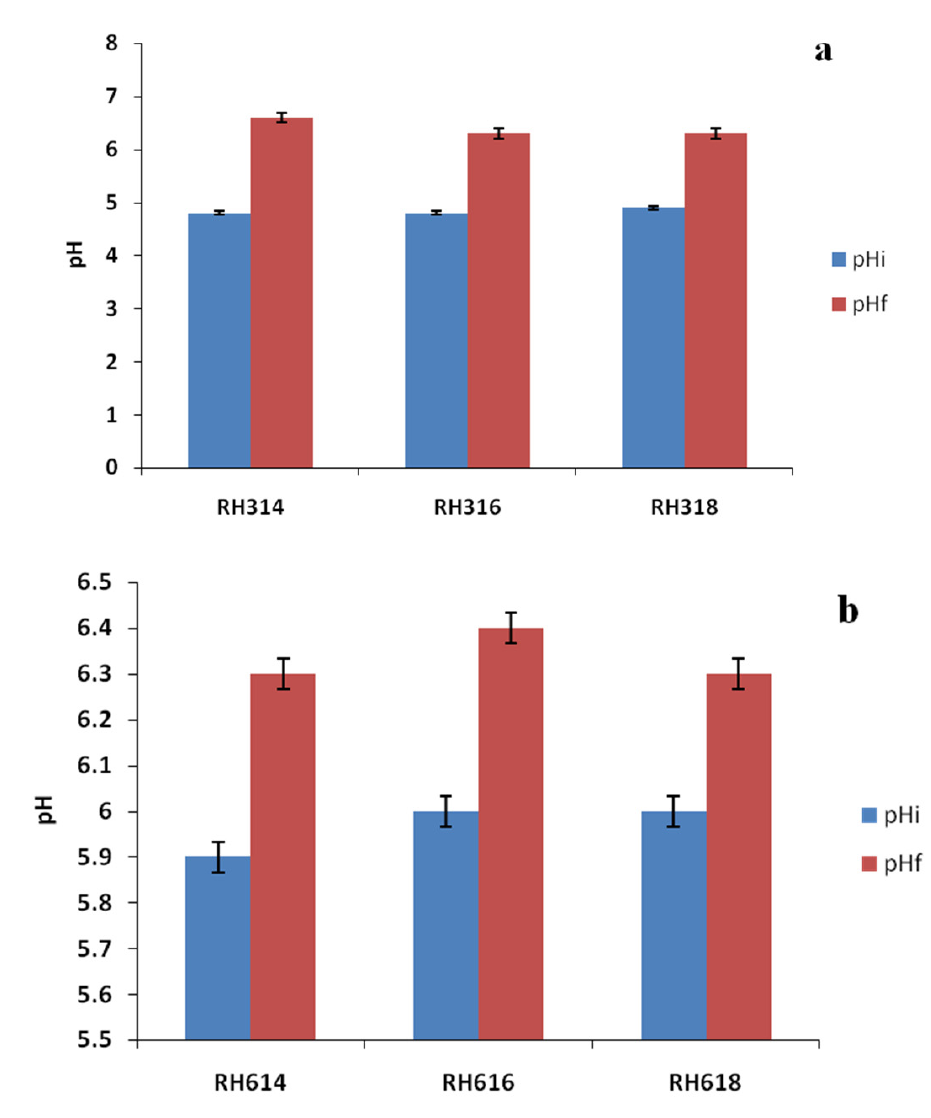
Figure 2. Initial and final pH values of RH at particle sizes of 300 ( a ) and 600 μ m ( b ).